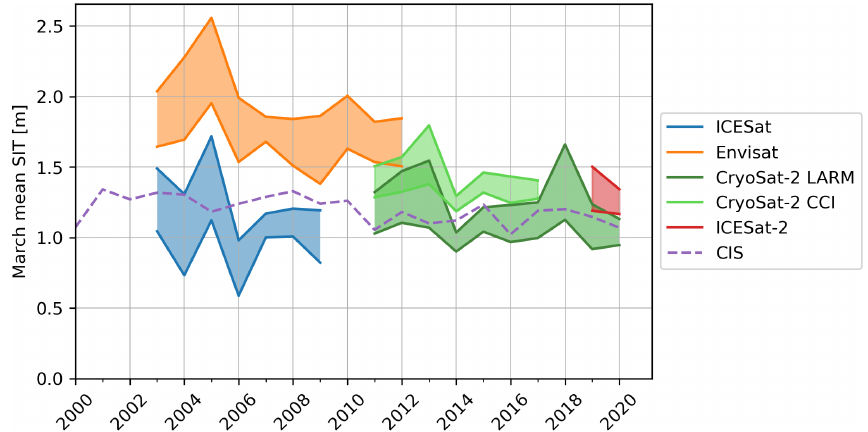
Figure 6. Time series of March mean sea ice thickness from the different satellite altimeters and the estimated sea ice thickness from CIS ice charts. The envelopes show the range of outcomes from different processing methods. Table 3. Trend in mean March sea ice thickness for ICESat and CryoSat-2 LARM (2003–2020) for different snow depth products and snow redistribution methods. The first values represent the W99 snow density values, and the italic values represent the SnowModel-LG snow density product. The trend varies from − 22.5 to 17.0cm per decade across the full range of processing methods (results in bold are significant within p < 0 . 05). W99 [cm per decade] PMW [cm per decade] SnowModel-LG [cm per decade] No redistribution − 12.9 15.6 4.2 − 19.0 8.3 − 1.5 Sigmoidal function − 16.5 4.8 − 4.0 − 22.5 − 2.5 − 9.6 Piecewise function − 14.0 17.0 3.8 − 19.5 11.2 −